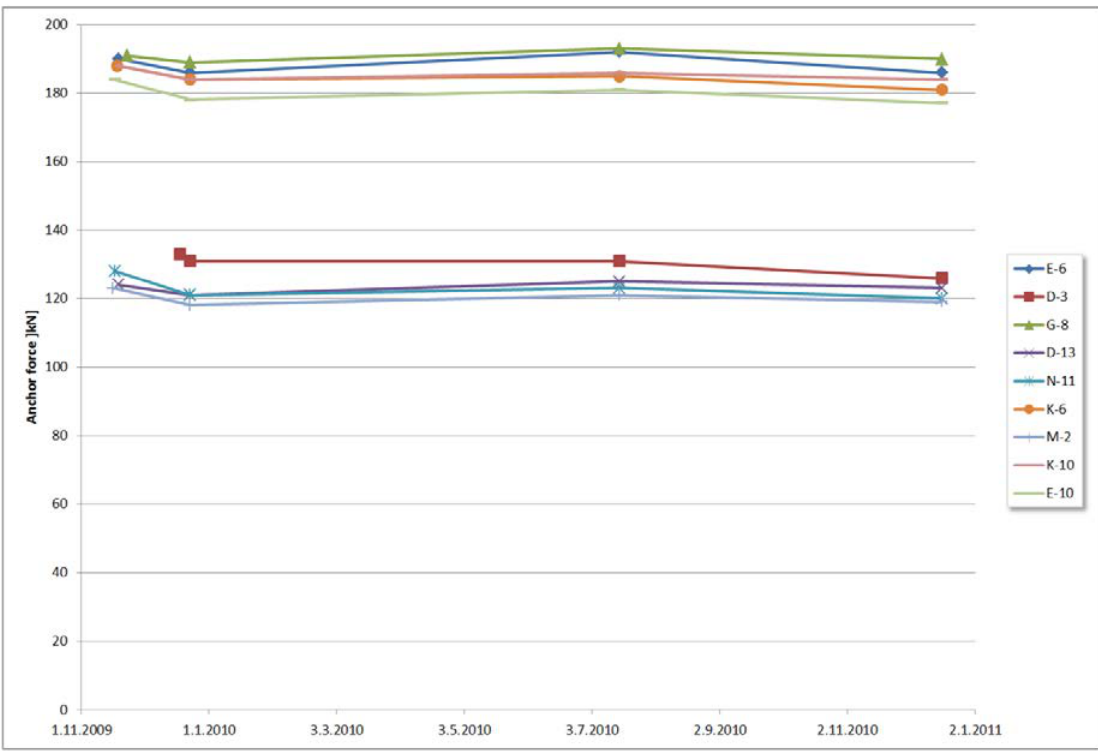
Figure 7. Diagram of the measured forces in measuring anchors (measuring anchors are annotated in Figure 5a).